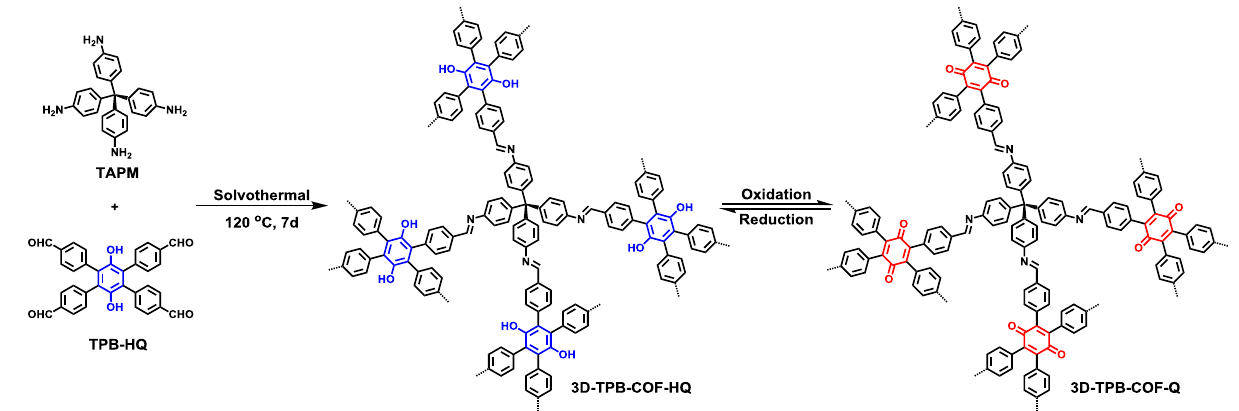
Fig. 1 Chemical Structure. Schematic representation of the synthesis and redox-triggered switching behavior of 3D-TPB-COF-HQ.